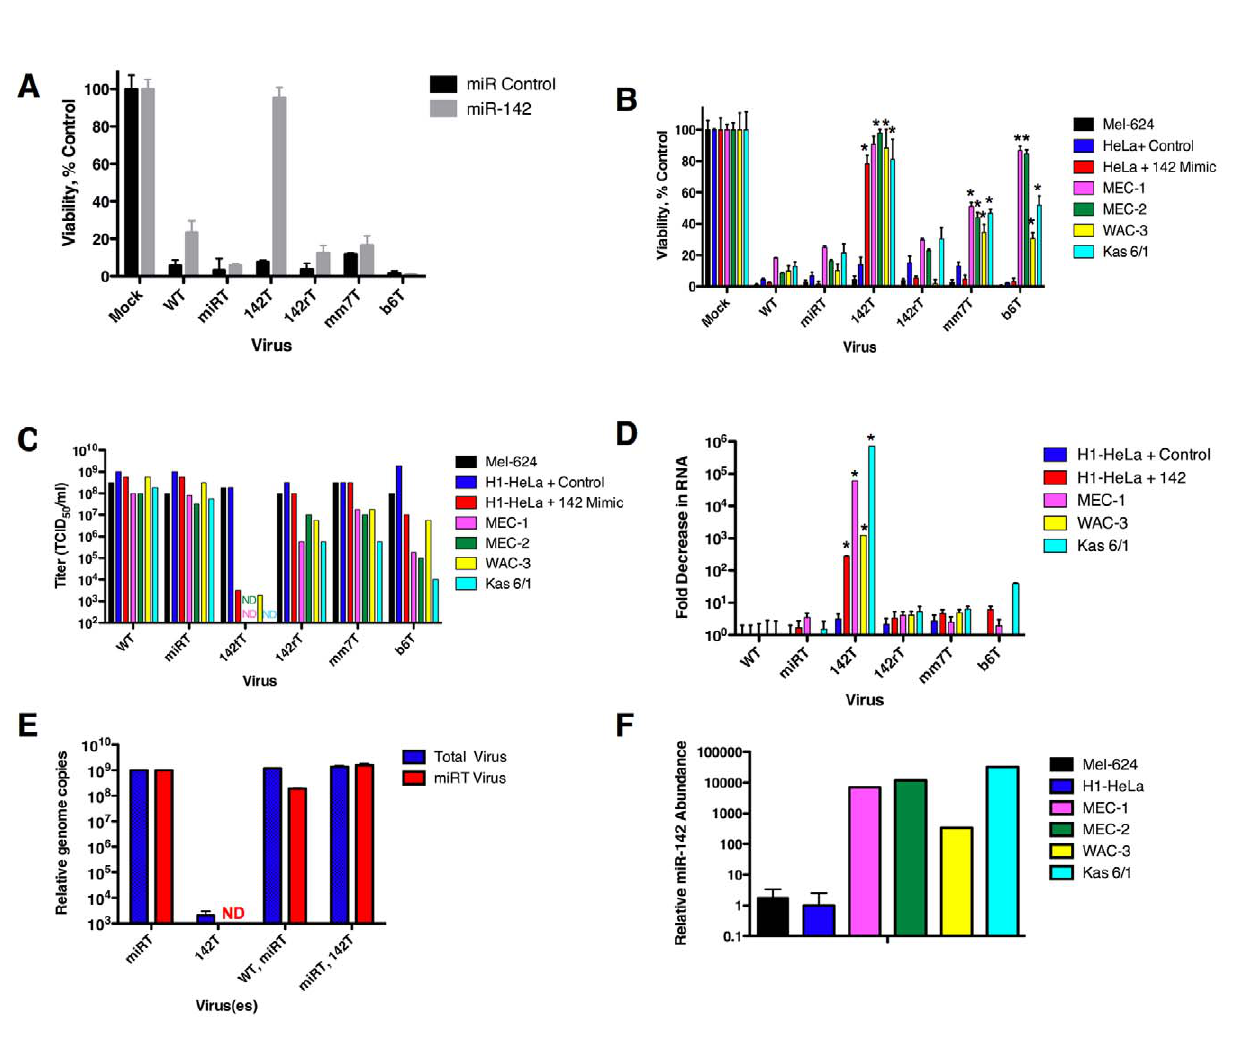
Figure 2. Translational suppression of CVA21 occurs in the presence of high endogenous miRNAs. (A) Viability 48 hrs. post infection with MOI=1.0 recombinant CVA21s in the presence of 200 nM control or miR-142 mimic. (B) Viability 48 hrs. post infection with MOI=1.0 in a panel of hematopoetic or control cell lines or in H1-HeLa cells transfected with 200 nM control or miR-142-3p mimics. (C) Infectious titer in cell supernatant in (B), titrated on H1-HeLa cells and assayed 72 hrs. post infection. (D) Fold decrease in CVA21 RNA 48 hrs. post infection at MOI=1.0 of hematopoetic cell lines or in trans supplemented miRNA mimic. Fold decrease normalized to GAPDH expression. (E) Relative CVA21 genome copies in singly or doubly infected MEC-1 cells as quantified by qPCR. Primers and probes in 2A region of CVA21 or miRT region of CVA21 genome quantified total or miRT viral genomes, respectively. (F) Relative miR-142-3p abundance in a panel of cell lines. Small RNA was extracted from cells and reverse- transcription and qPCR analysis of miR-142 3p was performed. Abundance correlated to expression in H1-HeLa cells (per 5 ng small RNA). *p= , .01 vs. H1-HeLa + Control; ND- none detected.